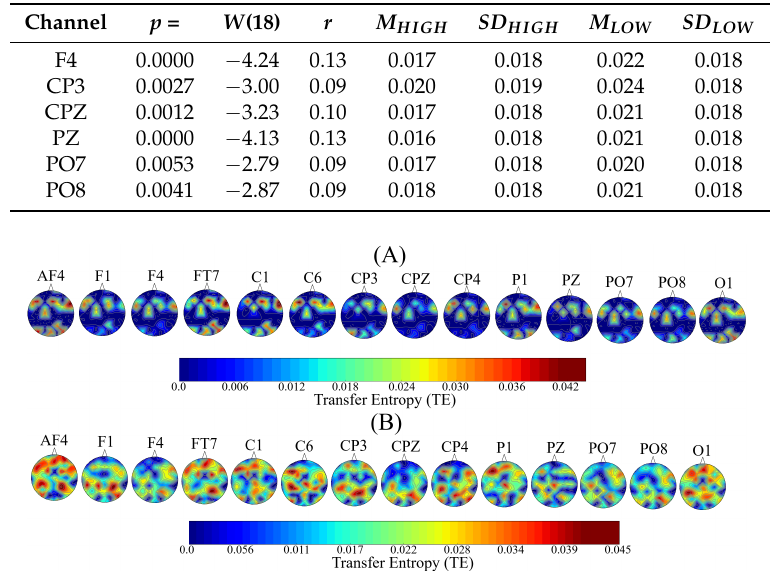
Table A10. Eyes-Open (EO) setting. Channel-wise paired Wilcoxon rank sum tests for six channels (F4, CP3,. CPZ, PZ, PO7, and PO8) in which significantly higher distributed TEs were associated with LOW stress-susceptible group. p , W , and r refer to p -value, test-statistics, and the effect size for Wilcoxon rank sum tests. M and SD are the mean and standard deviation of these channels’ distributed TE values for HIGH and LOW stress-susceptible groups. The subscripts to M and SD mark the two groups.